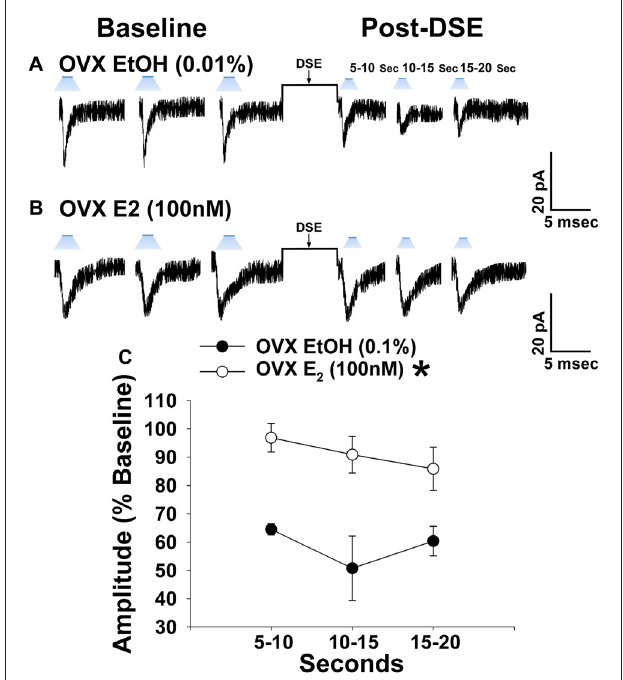
FIGURE 8 | E 2 significantly attenuates retrograde EC inhibition of leEPSC amplitude in POMC neurons from ovariectomized NR5A1-cre mice. LeEPSC amplitude is reduced post-DSE in recordings from EtOH-treated slices (0.01%; A ; n = 5). However when other slices are treated with E 2 (100 nM; n = 7), the degree of reduction is significantly reduced (B) . These points are further illustrates by the data shown in the line graph in (C) Bars represent means and vertical lines 1 SEM. ∗ P < 0.05; rank-transformed multifactorial ANOVA/LSD.